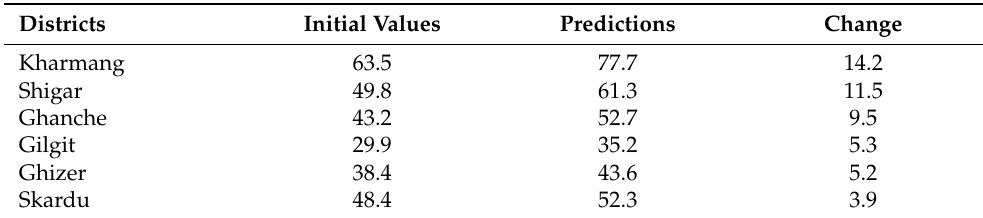
Table 4. Predictions and the observed change in case of the second scenario—10% growth in climate vulnerability (most affected